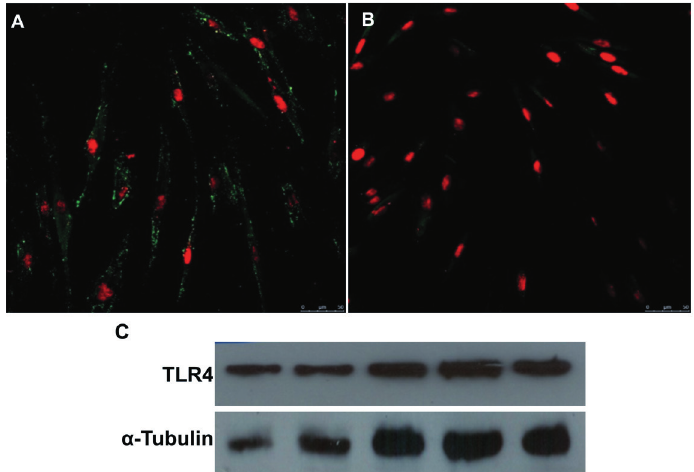
Figure 2- Highly purified CD105+ subsets of periodontal ligament (PDL) cells express Toll-like receptor 4 (TLR4). (A) Positive immunofluorescence for the TLR4 with nuclear localization confirmed by TO-PRO ® -3 staining. (B) Control are represented by PDL-CD105 + cells incubated only with secondary antibody. (C) Western blotting analysis confirmed TLR4 in the five PDL-CD105+